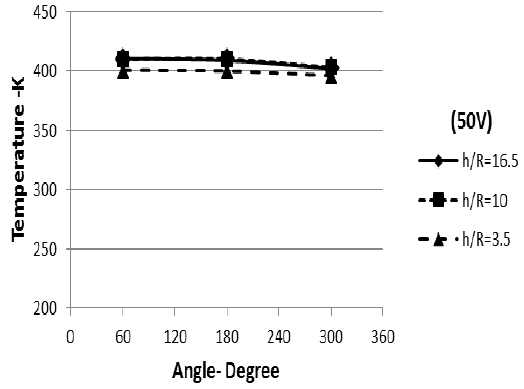
Figure 10. Average face temperature with different depth/radius ratios at a voltage of 50 V.